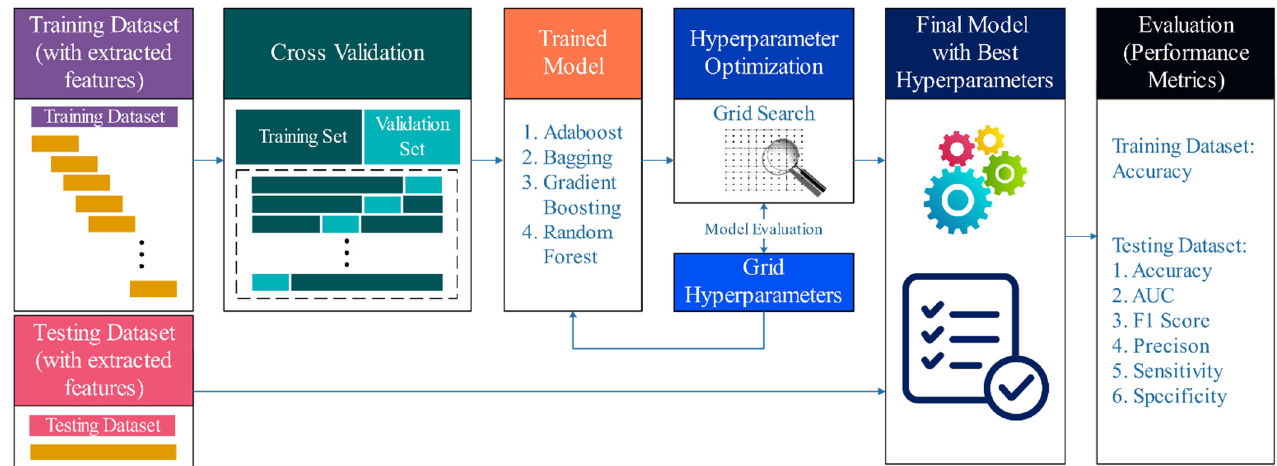
Figure 5. Data spliing, cross-validation, hyperparameter optimization, and evaluation. Figure 5. Data splitting, cross-validation, hyperparameter optimization, and